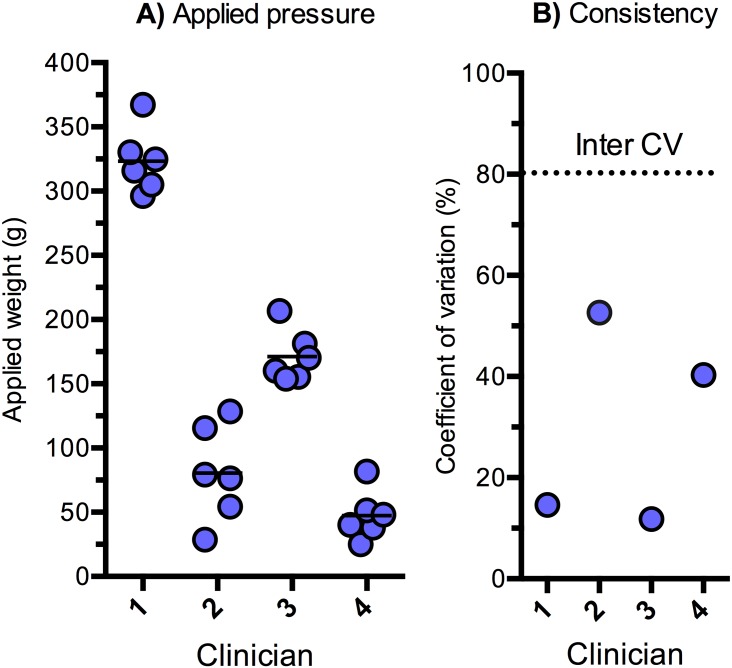
A) Shows individual lancet peak weight measurements from four different clinicians (no. 1–4). The horizontal lines denote the arithmetic mean for each individual. B) Shows intra-reliability and inter-reliability (dotted horizontal line) of applied weight expressed as the coefficient of variation (standard deviation expressed as % of the mean) for each of the four testees and between the four testees. CV% = Coefficient of variation (calculated as the ratio between the standard deviation and the mean in %).